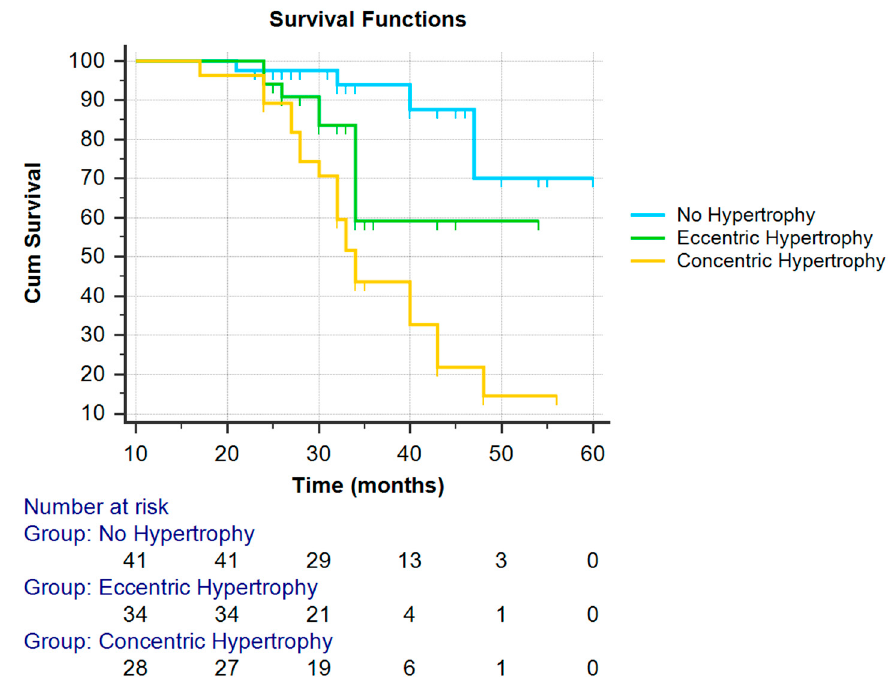
Figure 1. Cardiovascular mortality according to left ventricular geometry (Kaplan–Meier Analysis).